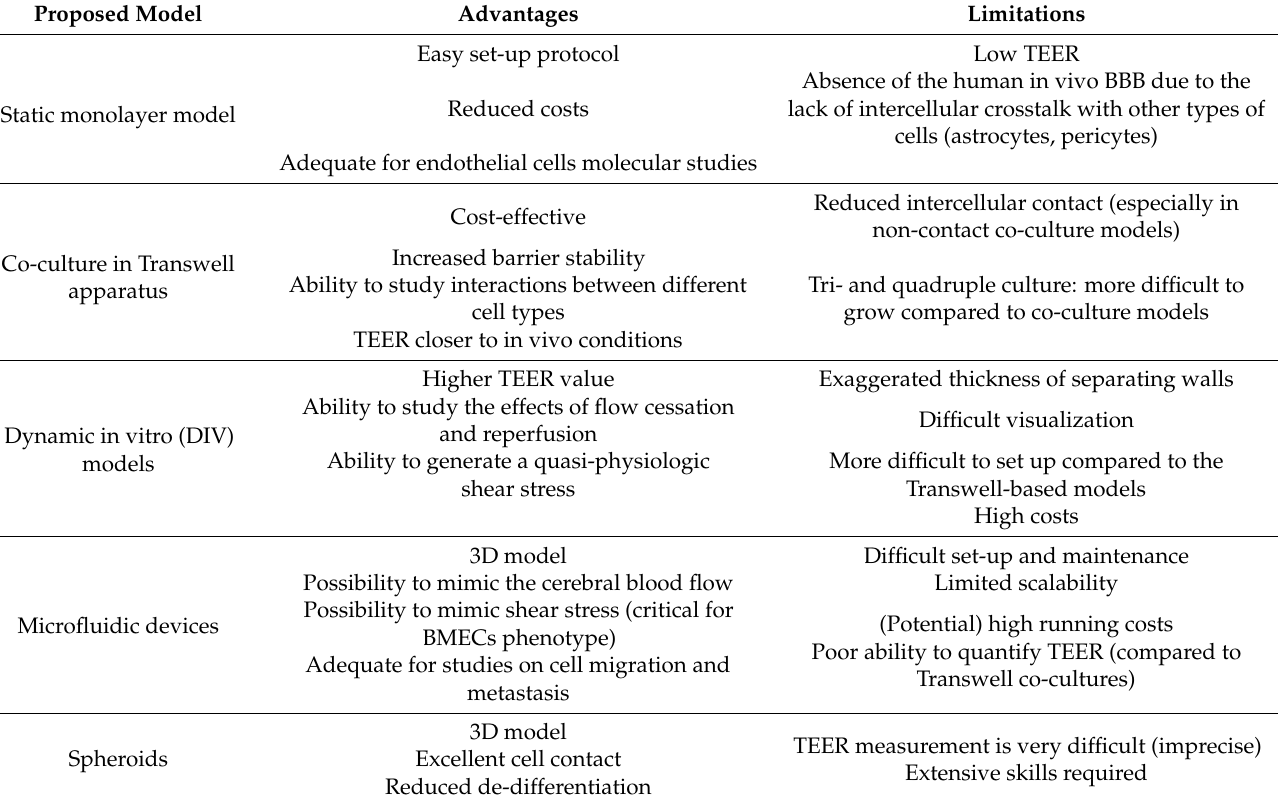
Table 2. BBB in vitro models –advantages and